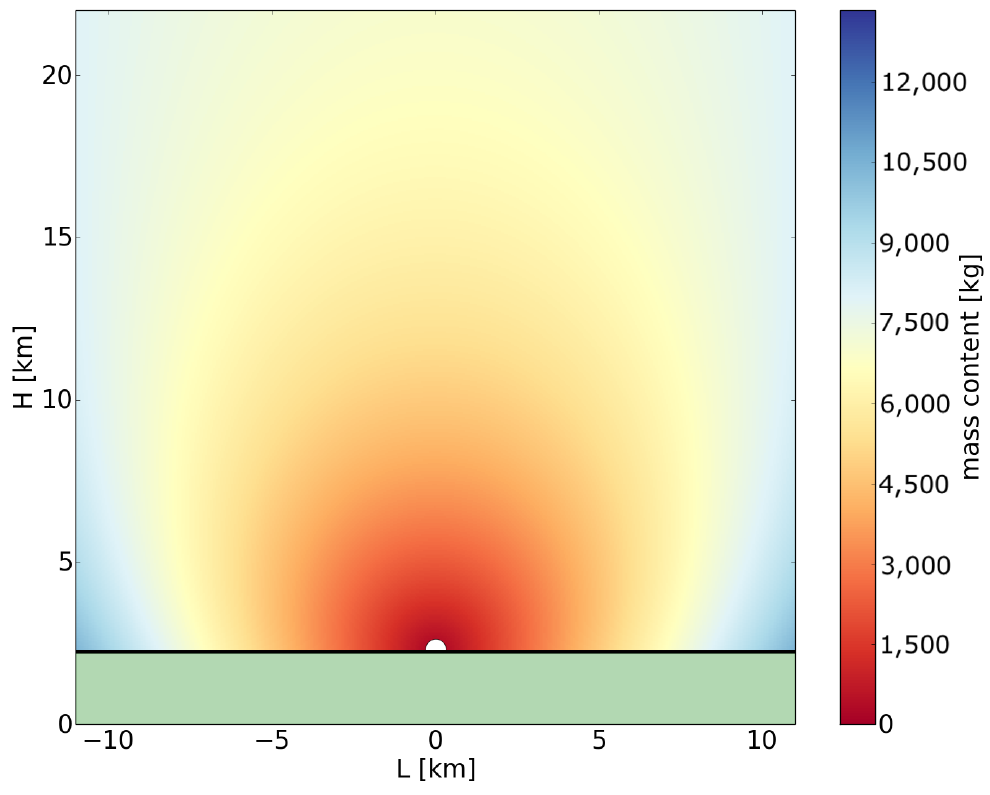
Figure 2. Atmospheric mass content in the surroundings of the Gamma-Flash ground-based exper- iment (white dome), obtained by evaluating the amount of matter contained in a unitary column going from ( L , H ) = (0.0 km, 0.0 km) to the surrounding positions. As the atmospheric density profile decreases exponentially with altitude H , the distribution assumes an “egg shape”, making the mass content higher if moving along L , rather than along H